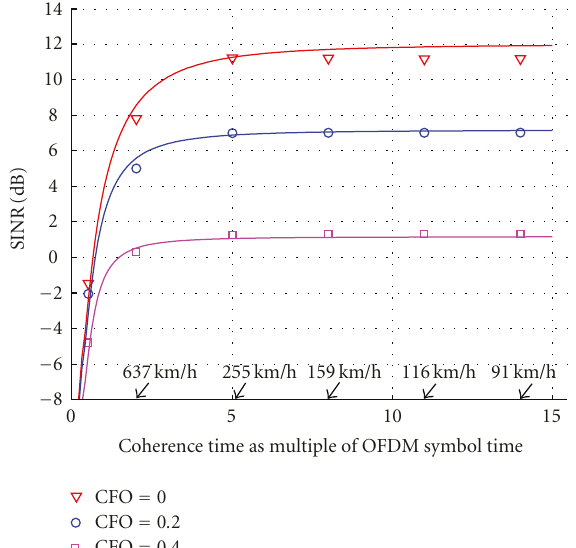
Figure 4: SINR as in Figure 3 with Γ = 12dB.